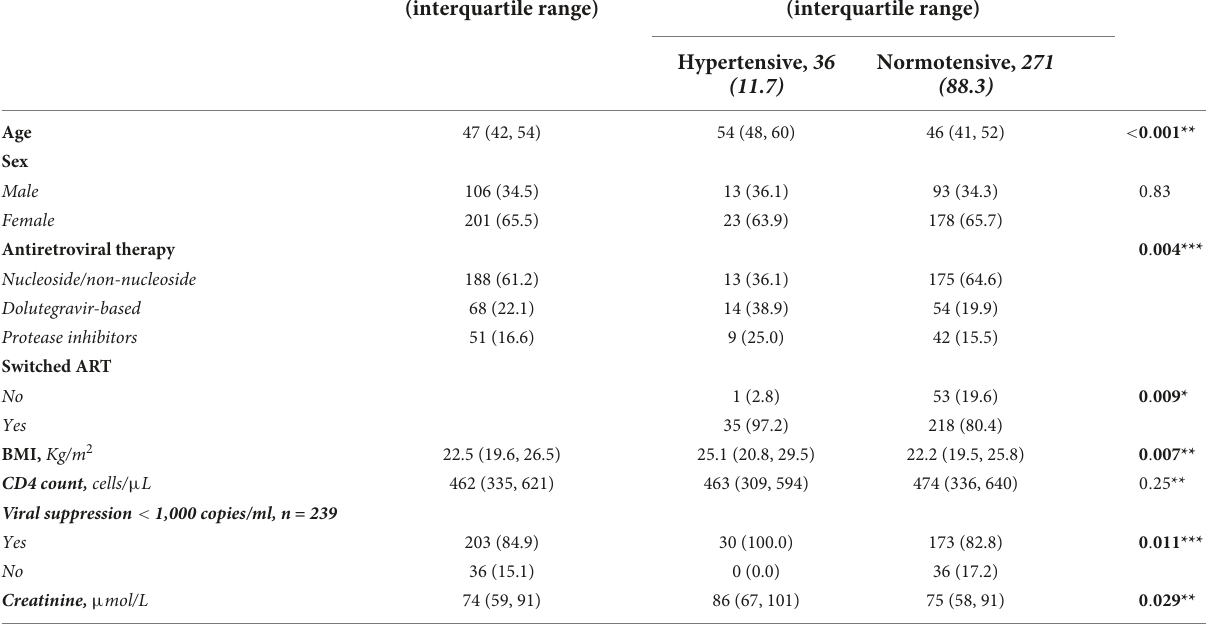
TABLE 1 Study characteristics and factors associated with incident hypertension. Variable Total, n (%) or median